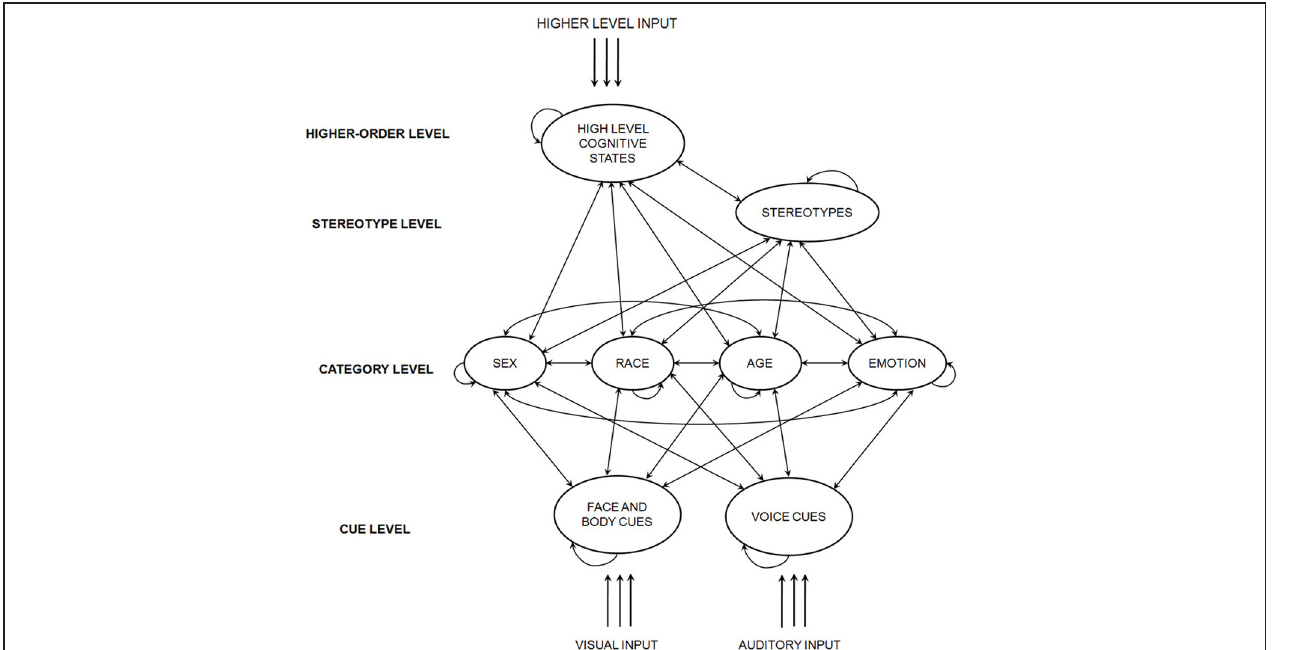
FIGURE 1 | A general diagram of the dynamic interactive model. Adapted from Freeman and Ambady (2011a).